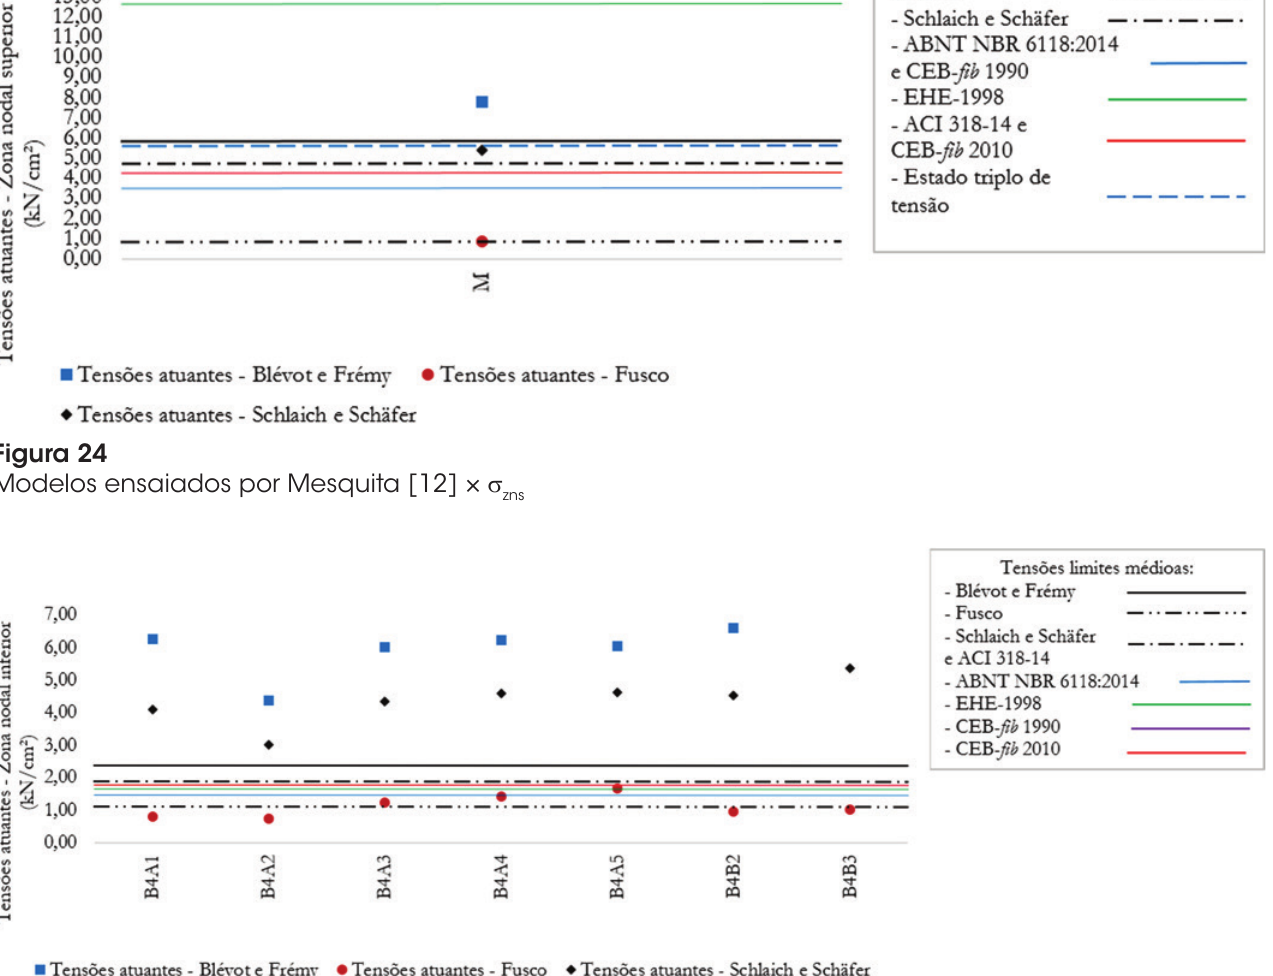
Modelos ensaiados por Cao e Bloodworth [13] × σ